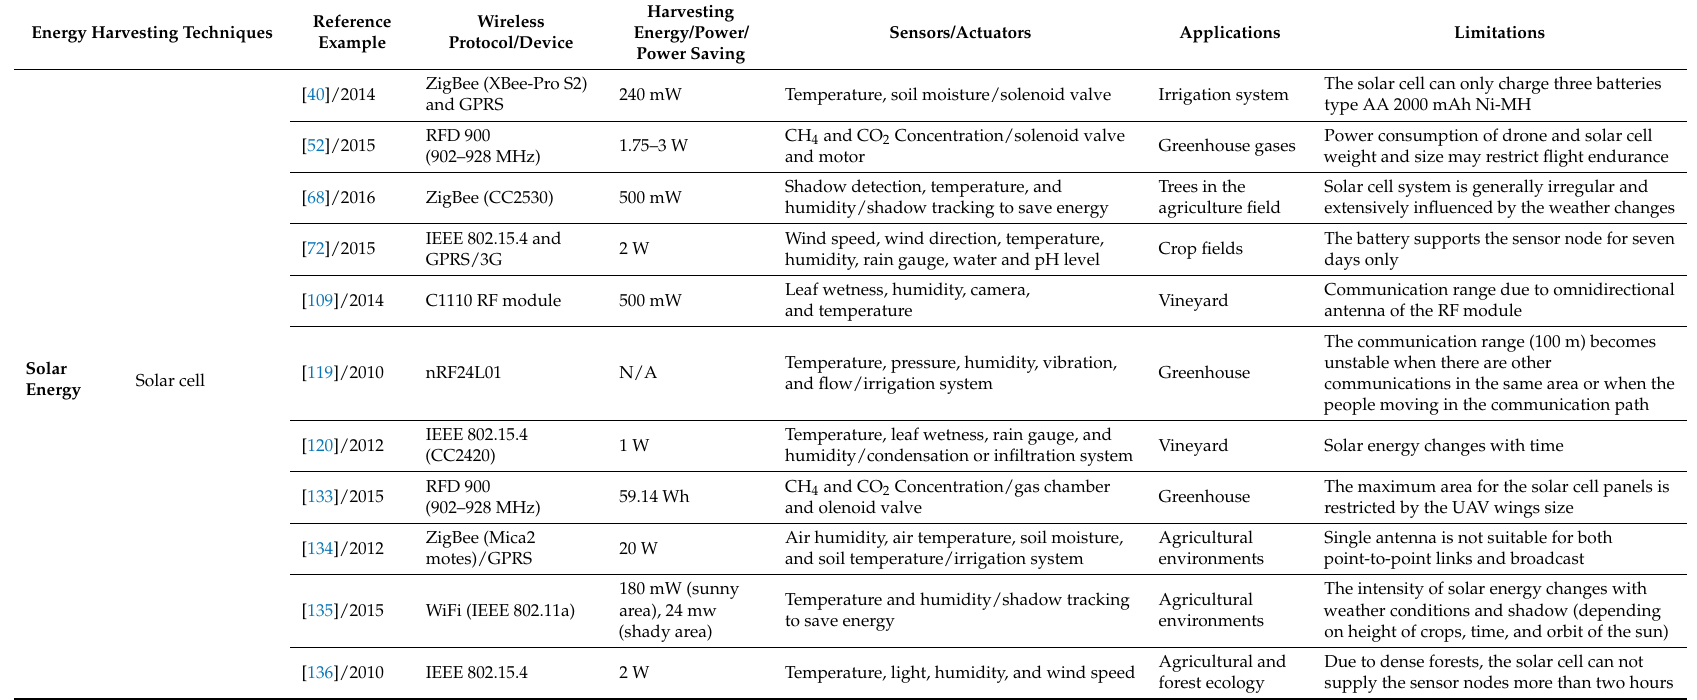
Table 7. Energy-harvesting techniques for previous research works used in agricultural